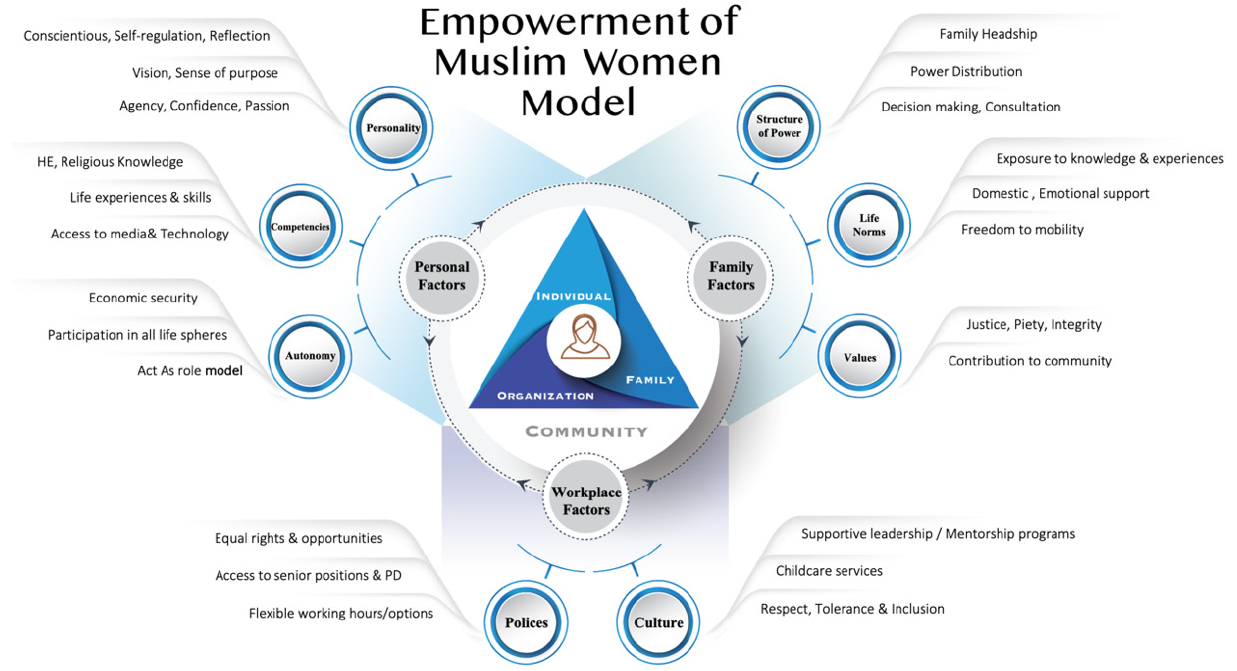
Figure 1. Empowerment of Muslim Women Model.